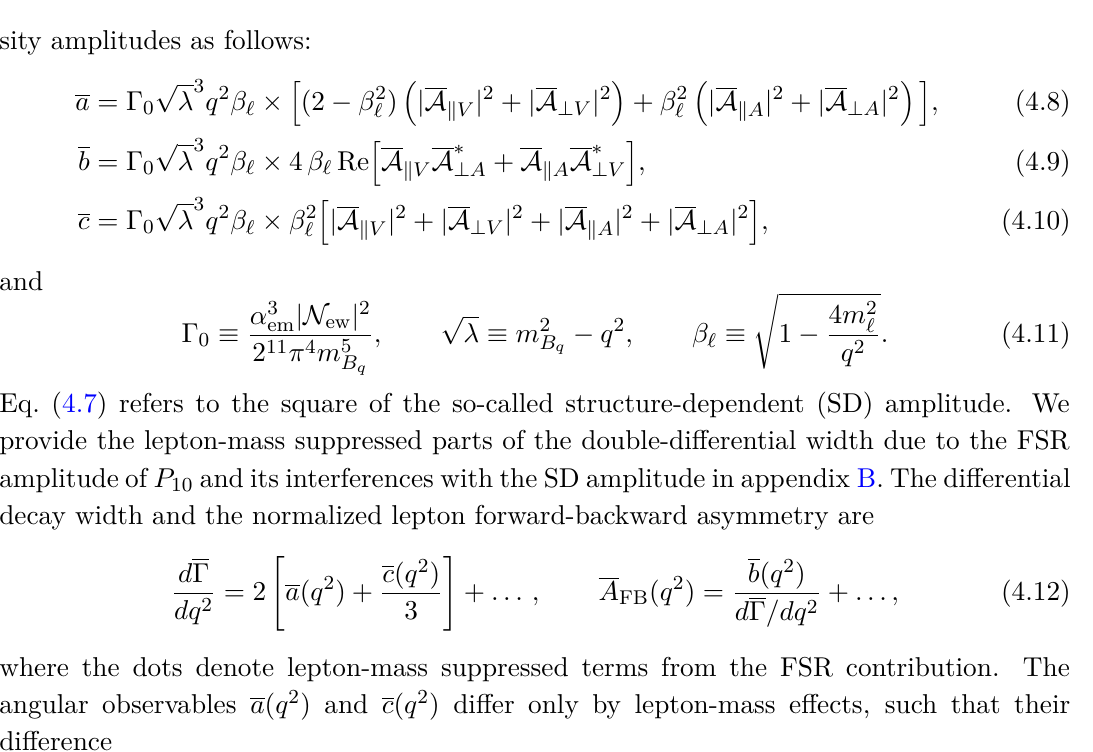
Figure 8 . The real [solid, darker] and imaginary [dashed, lighter] part of the combined LP and NLP result for A LV in the default 1- and 2-Res model for q = s [left] and q = d [right], respectively. The grey band shows the variation r LP = 0 . 2 ± 0 . 2